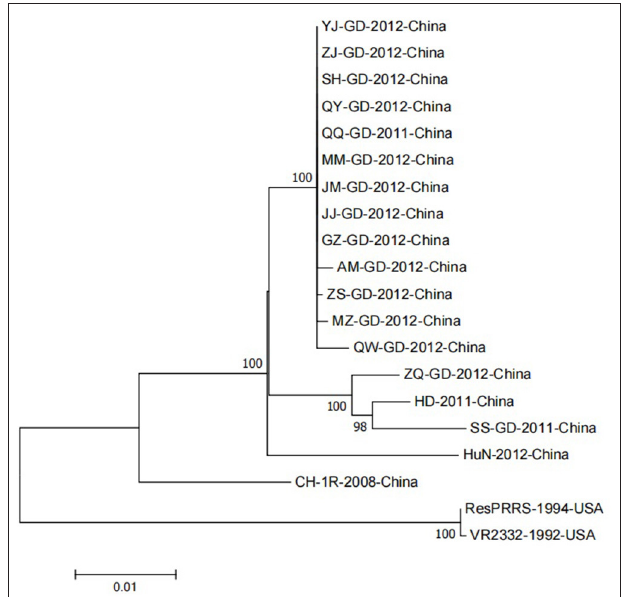
FIGURE 2 | A neighbor-joining phylogenetic tree was constructed based on the NSP9 sequences of 20 PRRSV strains, using MEGA software (ver. 7.0; Center for Evolutionary Medicine and Informatics, Tempe, AZ) with 1000 bootstrap replicates.